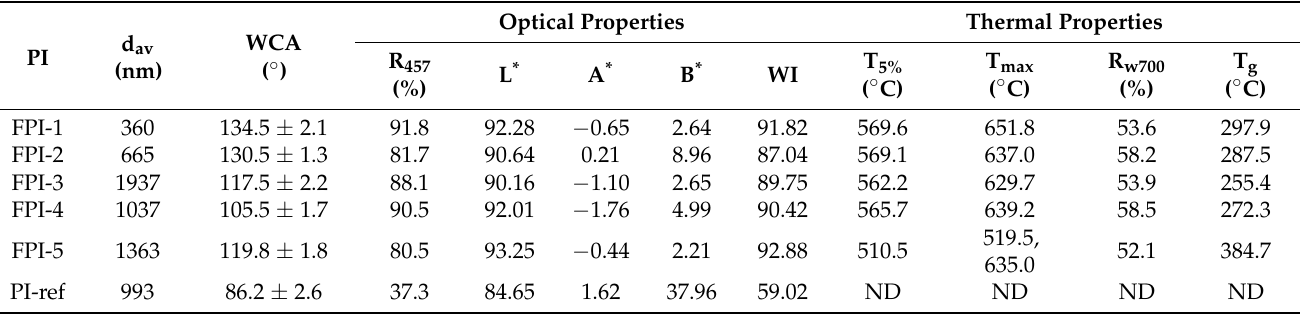
Table 2. Optical and thermal properties of FPI